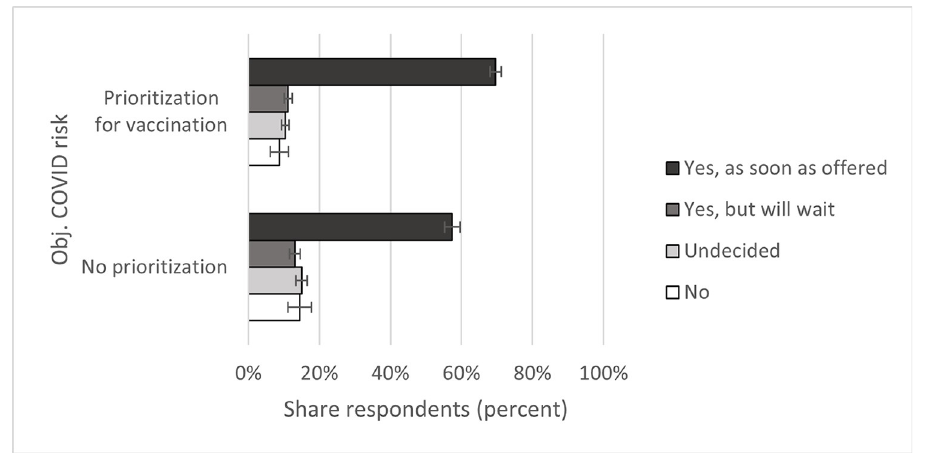
Fig 3. Official COVID risk and vaccine acceptance. Data: SOEP-CoV survey. Own calculations, weighted. 95% confidence intervals.